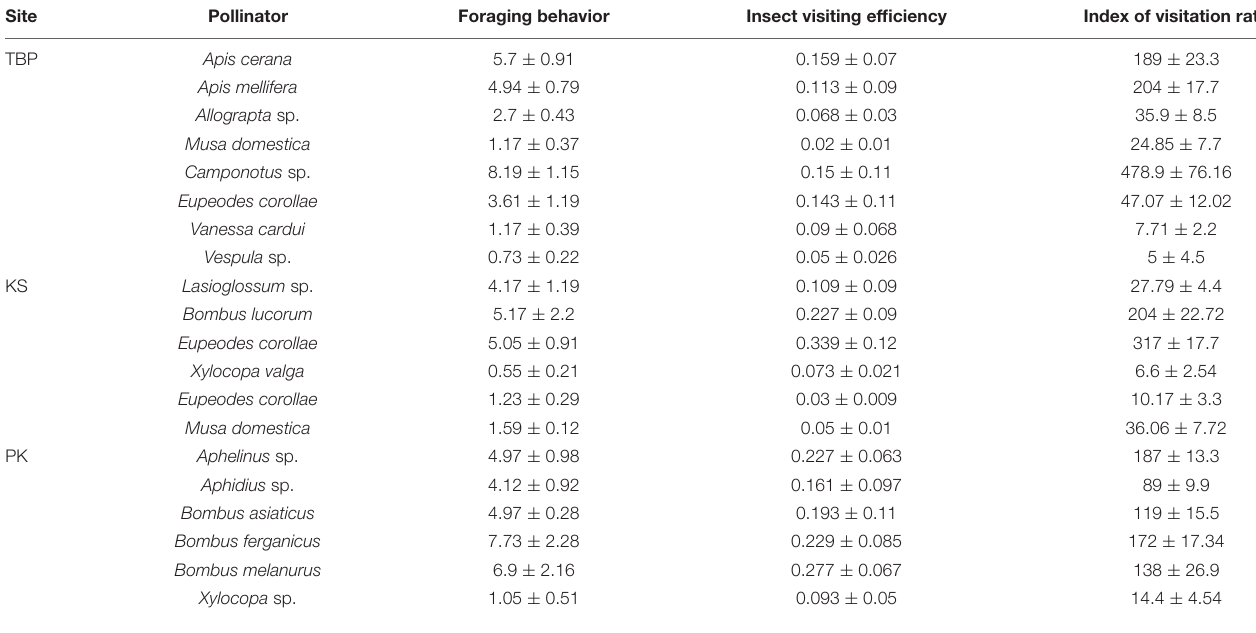
TABLE 7 | Pollination indices of different visitors across different study